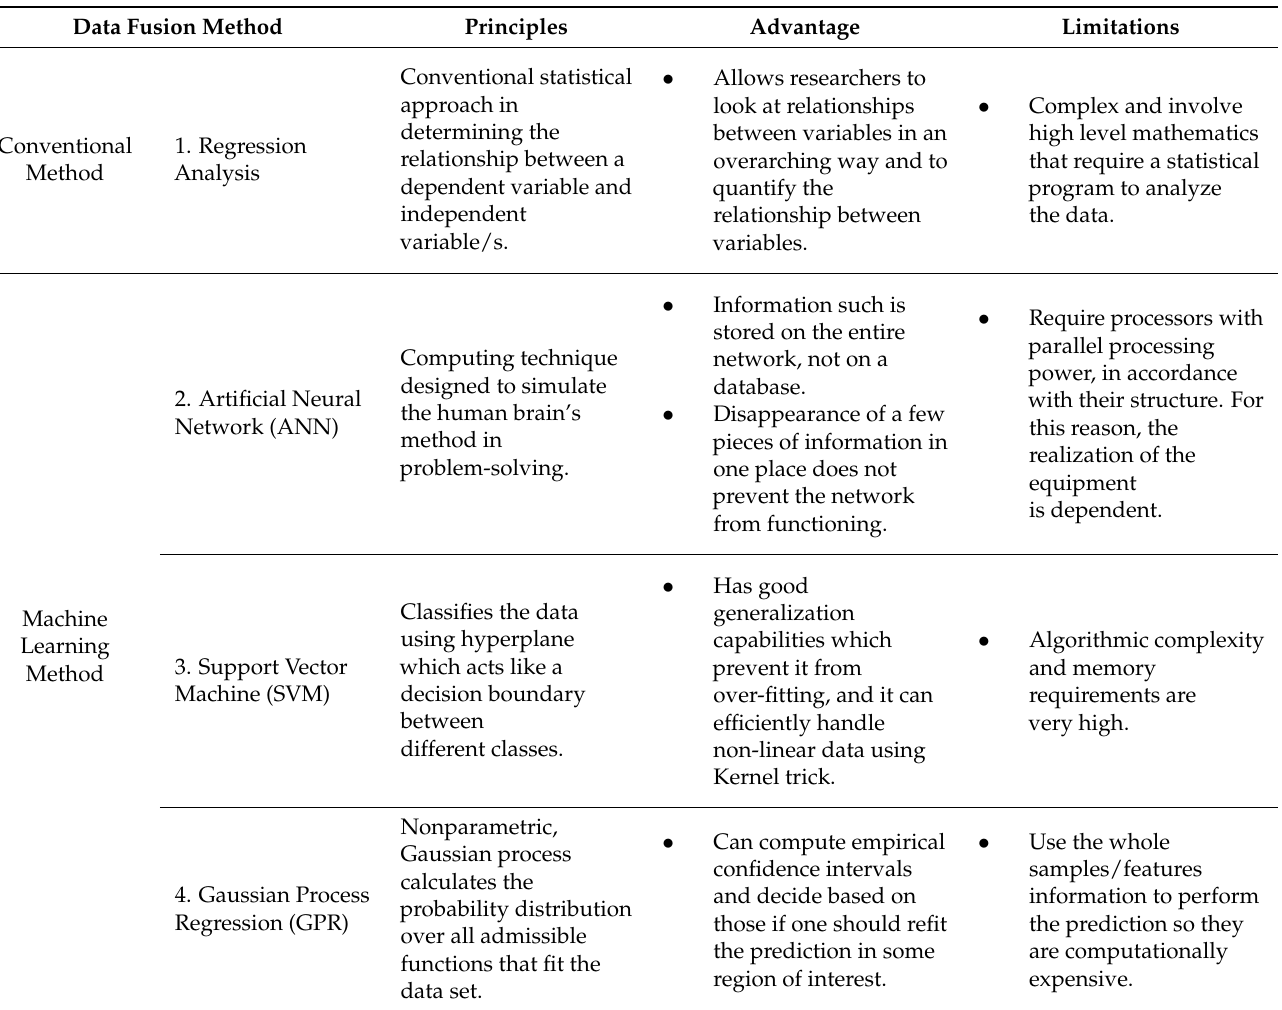
Table 1. Summary of principles, advantages and limitations of popular data fusion methods in prior